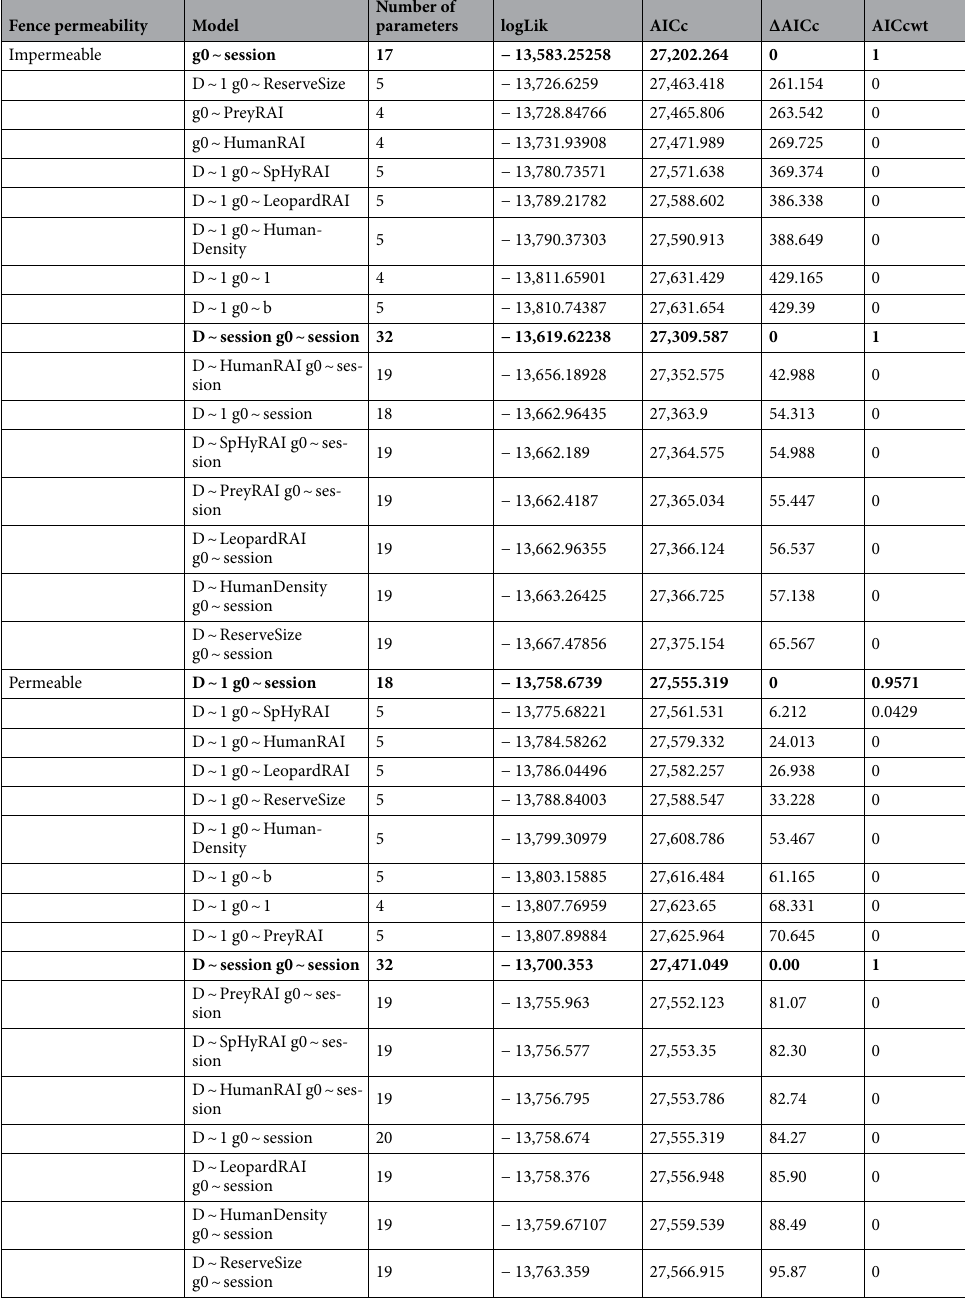
Table 2. Comparison of models of g0 and density fitted to camera trap data of brown hyaena captures across South Africa. Parameters include: D (density estimate) and g0 (baseline detection). Covariates include: b (learned response; g0 only); session (site), LeopardRAI (relative abundance index (RAI) of leopards), SpHyRAI (RAI of spotted hyaenas), HumanRAI (RAI of humans), HumanDensity (population density of humans) PreyRAI (RAI of prey species), ReserveSize (size of reserve). All models utilised the hazard rate detection function. Models shown in bold are the top models within each